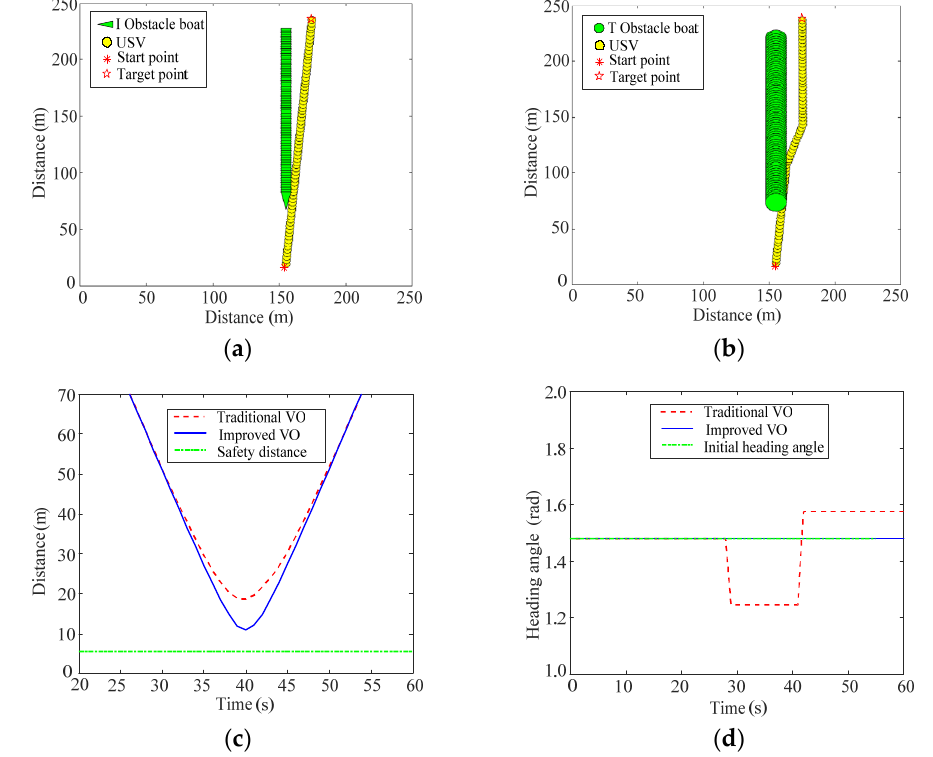
Figure 6. Comparison of whether to implement obstacle avoidance: ( a ) improved VO path simulation; ( b ) traditional VO path simulation; ( c ) relative distance comparison graph; ( d ) USV heading angle comparison chart.